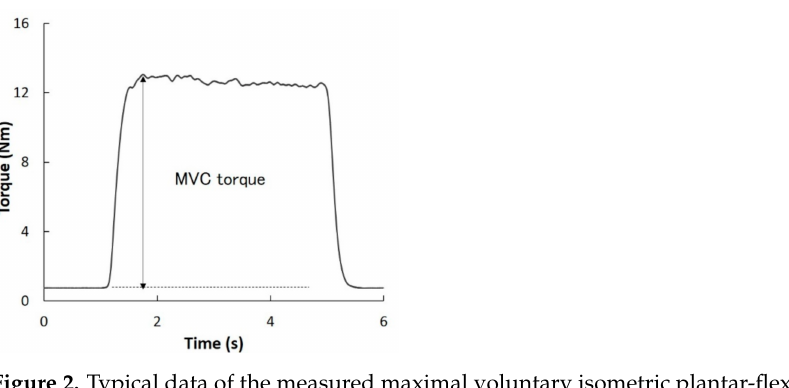
Figure 2. Typical data of the measured maximal voluntary isometric plantar-flexion torque of each metatarsophalangeal joint. Maximal voluntary isometric plantar-flexion torque was defined as the difference between the maximal torque during maximal voluntary isometric contraction (MVC) and passive torque at